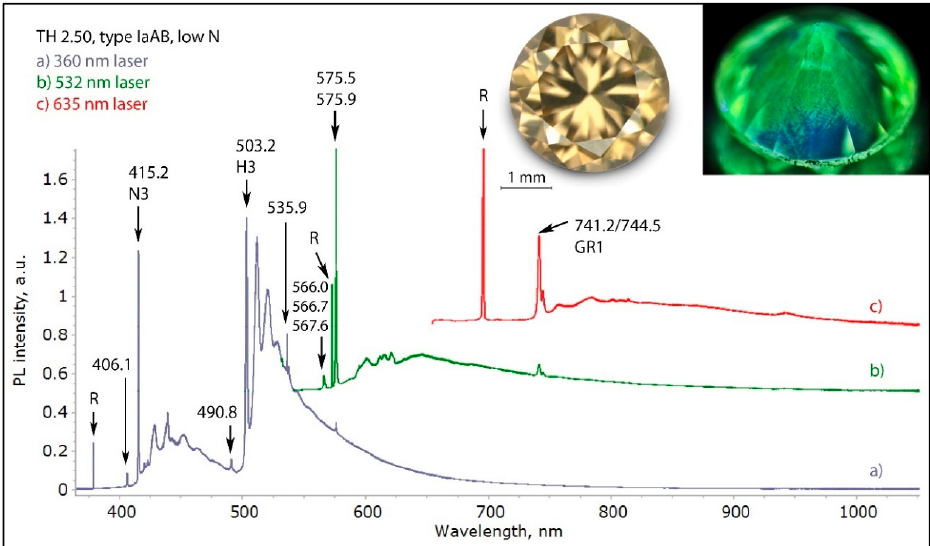
Figure 15. The low temperature PL spectra of a brown type IaB>A diamond with a deformation-related color, recorded with three different laser excitations. Interesting in this diamond is that the blue component of the fluorescence is not mainly caused by the N3 center, but by the 406.1 nm defect. This defect is very common in DR brown diamonds, but rarely as intense as seen here. The other very typical defects for DR brown diamonds are 490.8, H4, H3, 535.9, 576.0, 612.5 and the 617.6/626.1 nm center. While in most brown diamonds the H3 defect is responsible for the commonly observed green fluorescence, in this diamond the 490.8 nm defect is dominantly responsible for the green fluorescence seen in the photo (inset, right). The spectra were shifted vertically for clarity.